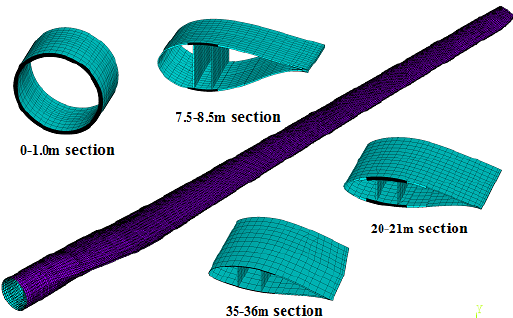
Figure 6. Finite Element Method (FEM) model of the blade.